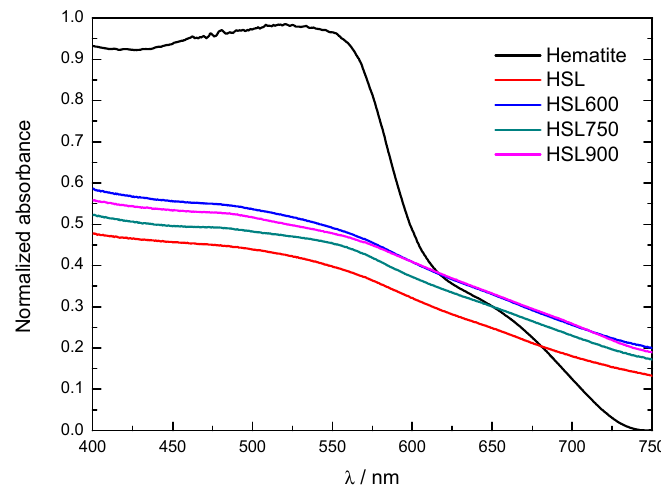
Figure 4. The absorption spectra for HSL type and Fe 2 O 3 samples.